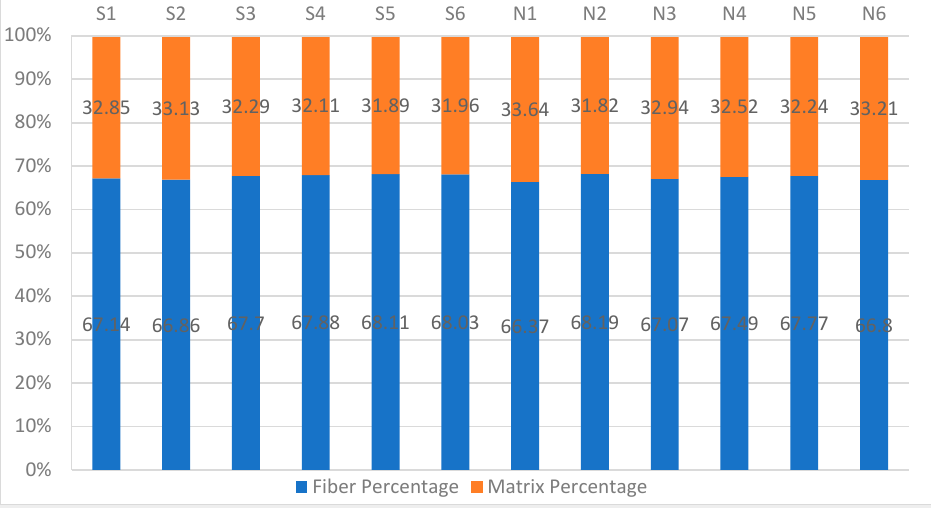
Figure 7. Mass constituent content by acid digestion.